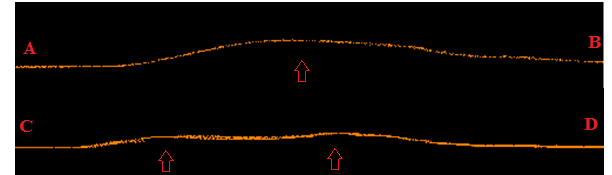
Figure 17. Profiles A-B and C-D of suspected structure – object 3